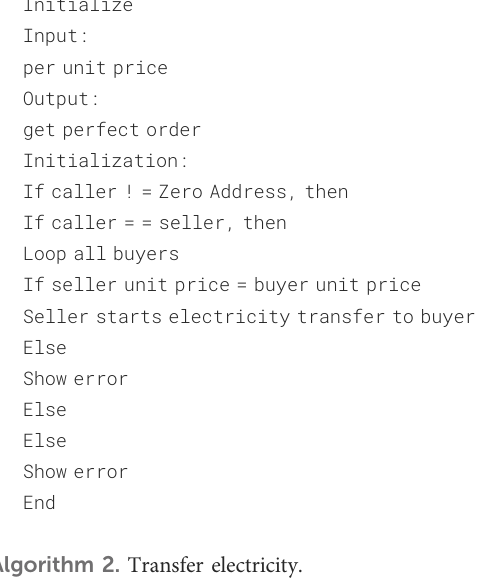
Algorithm 2. Transfer electricity.